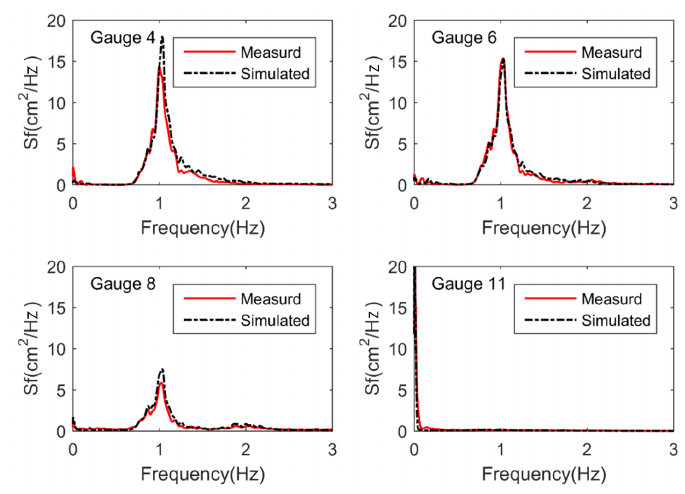
Figure 12. Comparison between the computed and measured wave energy spectra of four representative wave gauges for Case